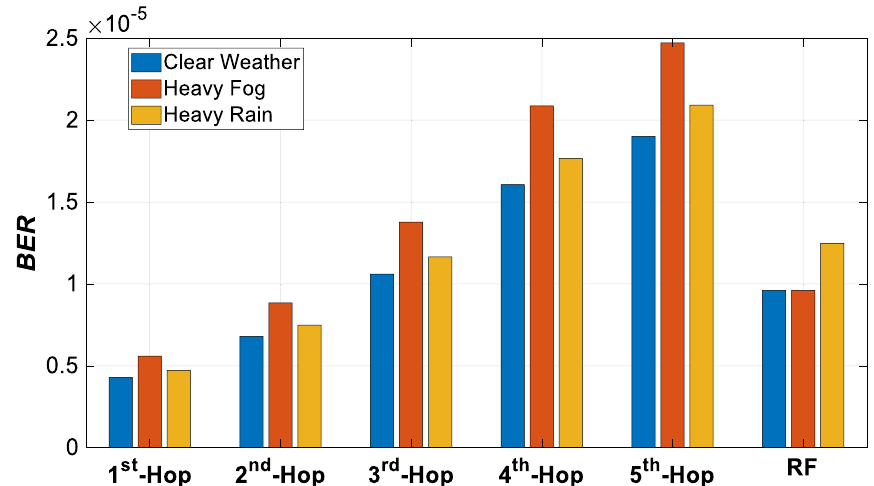
Fig. 7 The BER at different weather conditions. The BER at different weather conditions (i.e., clear weather, heavy fog, and heavy rain) in all communication scenarios. In general, the VLC and RF communication at clear weather conditions has the lowest BER compared to other weather conditions, while the VLC communication at foggy weather has the highest BER at VLC with low noticeable effect on RF because the fog even if it minimizes the visibility in the visible light band does not block the other electromagnetic radiations such as RF communication